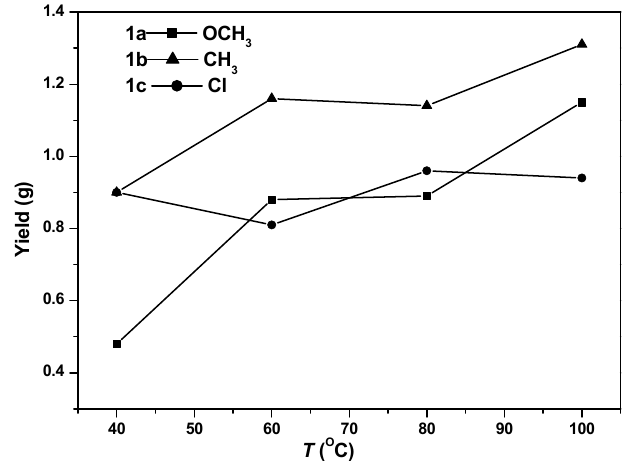
Figure 2. Polyethylene yield versus temperature for complexes 1a – 1c at 40, 60, 80 and 100 °C (Table 1).